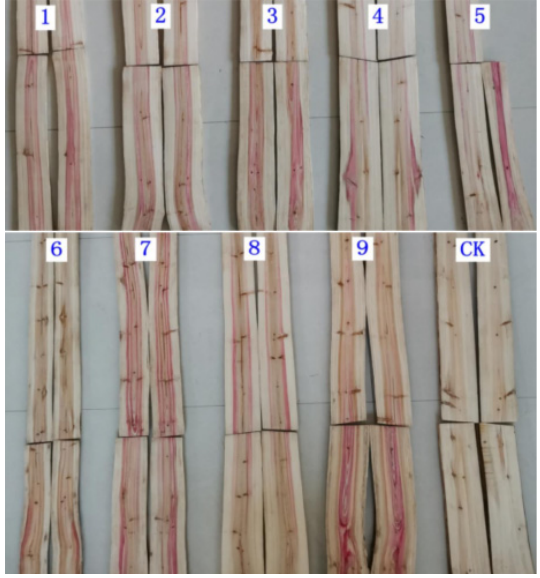
Figure 1. Dyed Chinese fir under different dyeing treatments. Note: After dyeing treatment, the color of wood in the experimental group 1-9 was significantly redder than that in CK.